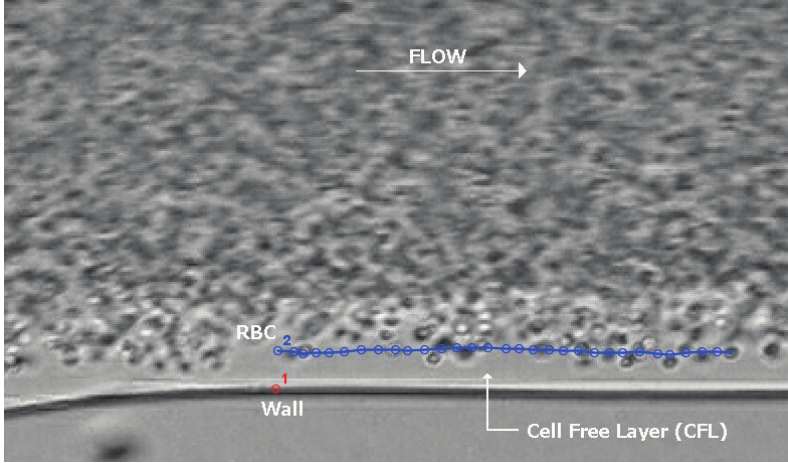
Figure 5. Tracking an individual red blood cell (RBC) flowing around the boundary of the RBCs